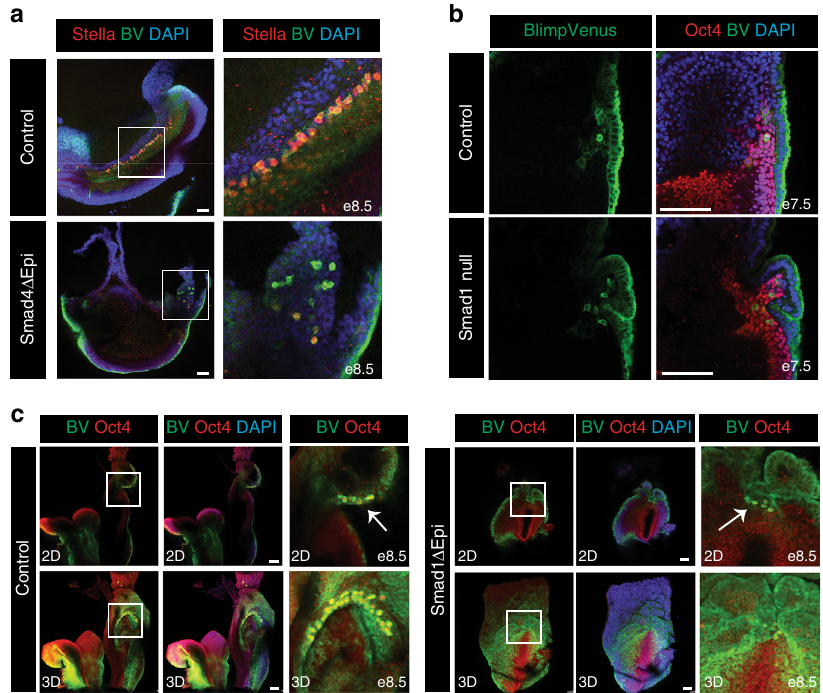
Fig. 3 Smad1 is required for PGC speci fi cation whereas Smad4 controls PGC maintenance and migration. a Stella staining at e8.5 shows PGCs migrating along the hindgut endoderm in BV + control but not Smad4 Δ Epi embryos. b Oct4 staining in Smad1 null and control e7.5 BV + embryos. c Single optical sections (2D) and z-stack projections (3D) showing Oct4 staining in the posterior side of Smad1 Δ Epi and control BV + embryos. Arrows indicate Oct4 and BV co-expressing cells. All IF images are counter stained with DAPI. Scale bars = 100 μ